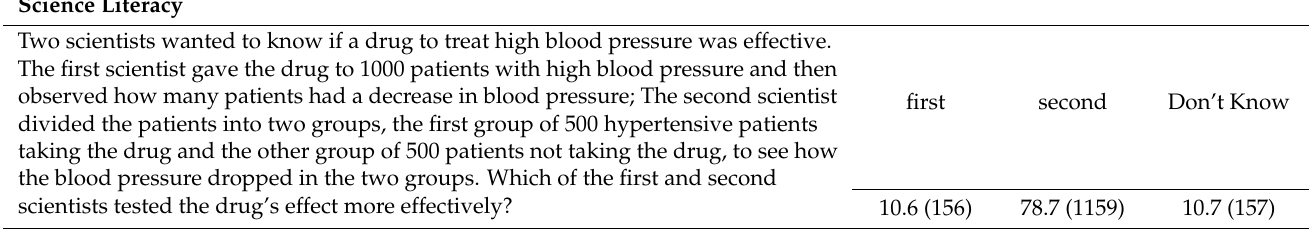
Table 9. Participants’ science literacy ( n =